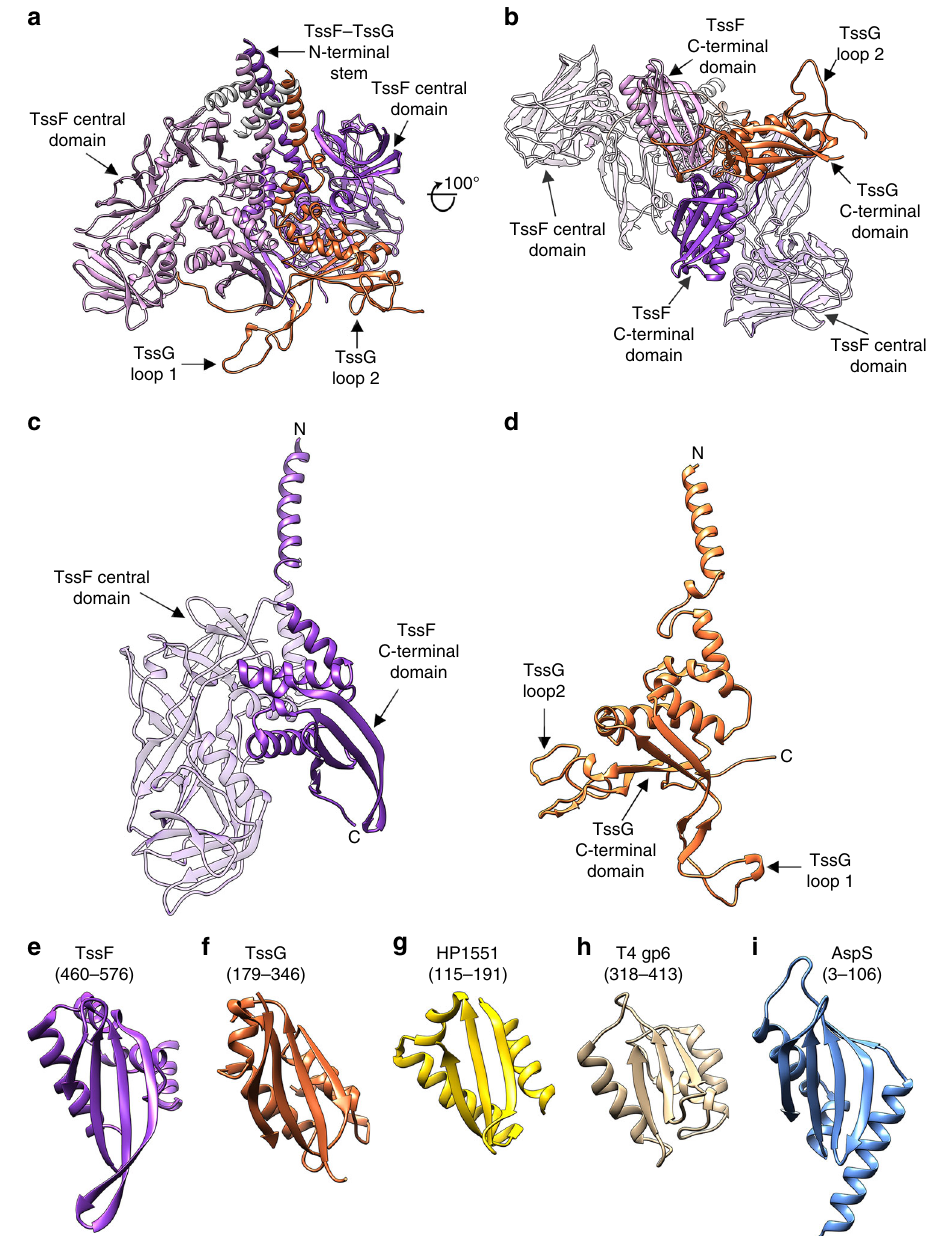
Fig. 5 Architecture of the TssF – TssG heterotrimer. a , b Ribbon diagrams of the TssF – TssG atomic model in two quasi-orthogonal orientations. c , d A TssF protomer c and a TssG protomer d oriented similarly to each other to emphasize their structural similarity. The TssF and TssG N- and C-termini are labeled. e , f The TssF e and TssG f C-terminal domains. g H. pylori T4SS HP1451 (gold, PDB ID 2PT7, 3.9 Å r.m.s.d. over 76 C α carbons aligned with TssF). h Phage T4 gp7 (tan, PDB ID 5IV5, 4.2 Å r.m.s.d. over 43 C α carbons aligned with TssF). i V. cholerae T2SS AspS pilotin (blue, PDB ID 4FTF, 2.7 Å r.m.s.d. over 62 C α carbons aligned with TssF). TssF and TssG are colored identically to Fig. 1 except for the TssF central domains, which are rendered semi- transparently in b , c for clarity. For e – i , the residue boundaries of the domains are shown in and functional traits with T4 gp6/gp7 and orthologous proteins found in other contractile phages 27,40,49 . The baseplate of some non-contractile phages, however, rely on a single unrelated pro- tein forming quasi-equivalent trimers, such as TP901 – 1 BppU 42 , to perform the same function. Methods Plasmid design and protein expression and puri fi cation . The plasmid for expression of the TssK SN – TssF – TssG complex (pCDF – TssK SN 6His – TssF – TssG) comprises three open-reading frames encoding TssK SN (residues 1 – 315) with a C- terminal His 6 -tag, full-length TssF, and TssG (residues 64 – 366) under the control